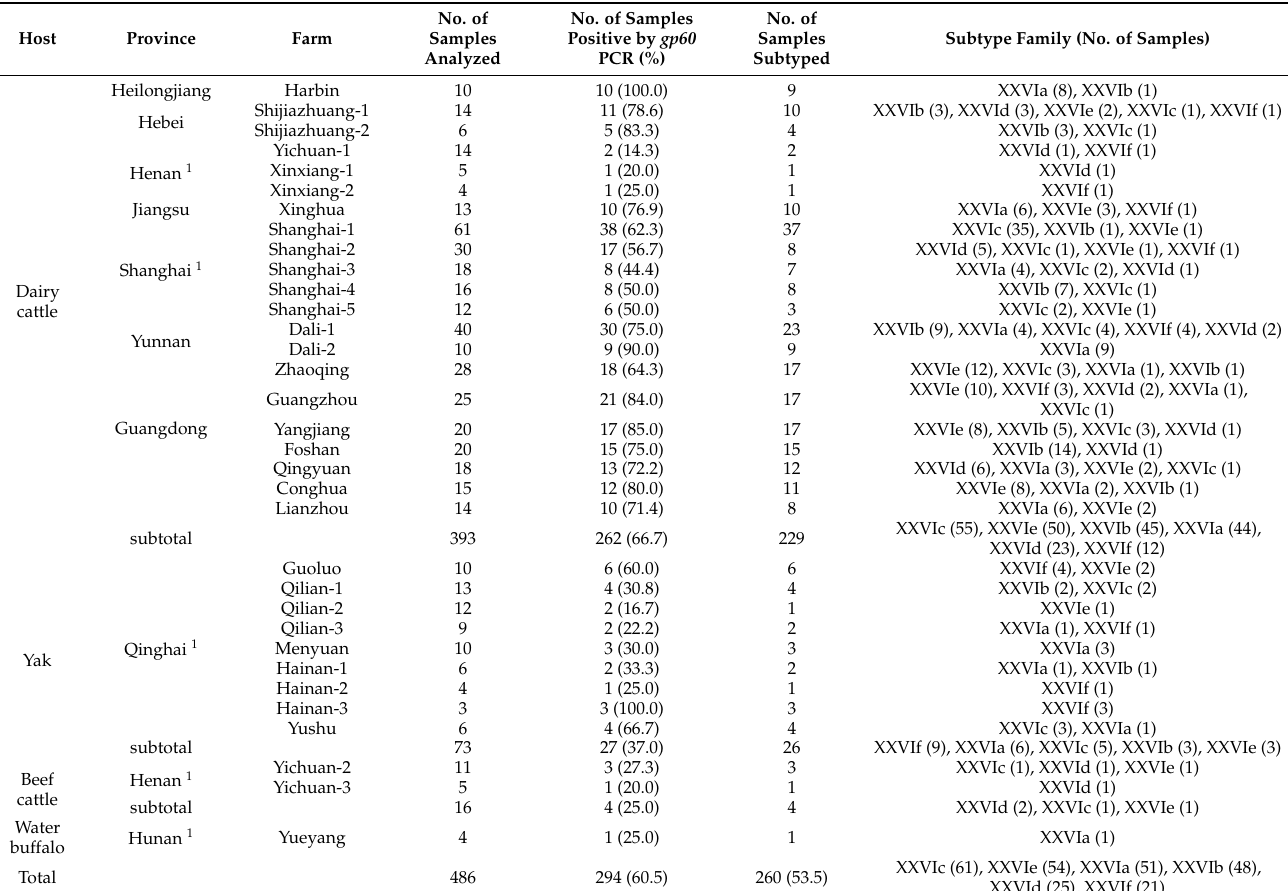
Table 1. Sources and subtype family identity of Cryptosporidium bovis samples used in the